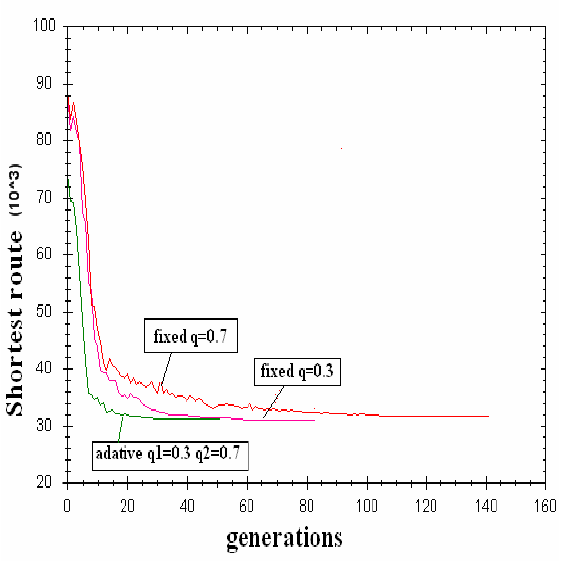
Figure8. The average result 3 of TSP benchmark instances Chn144 by different parameter q